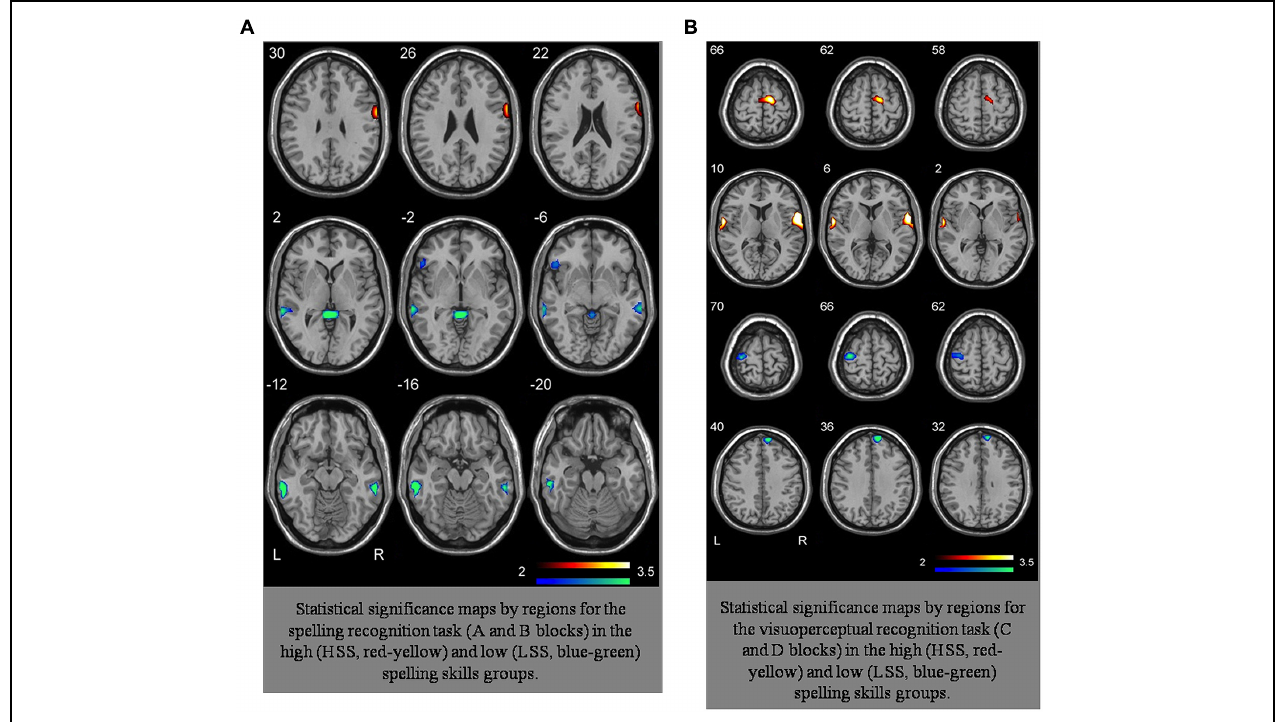
FIGURE 2 | (A) Representation of activation loci in A–B tasks HSS group and LSS group. (B) Representation of activation loci in C–D tasks HSS group and LSS group.